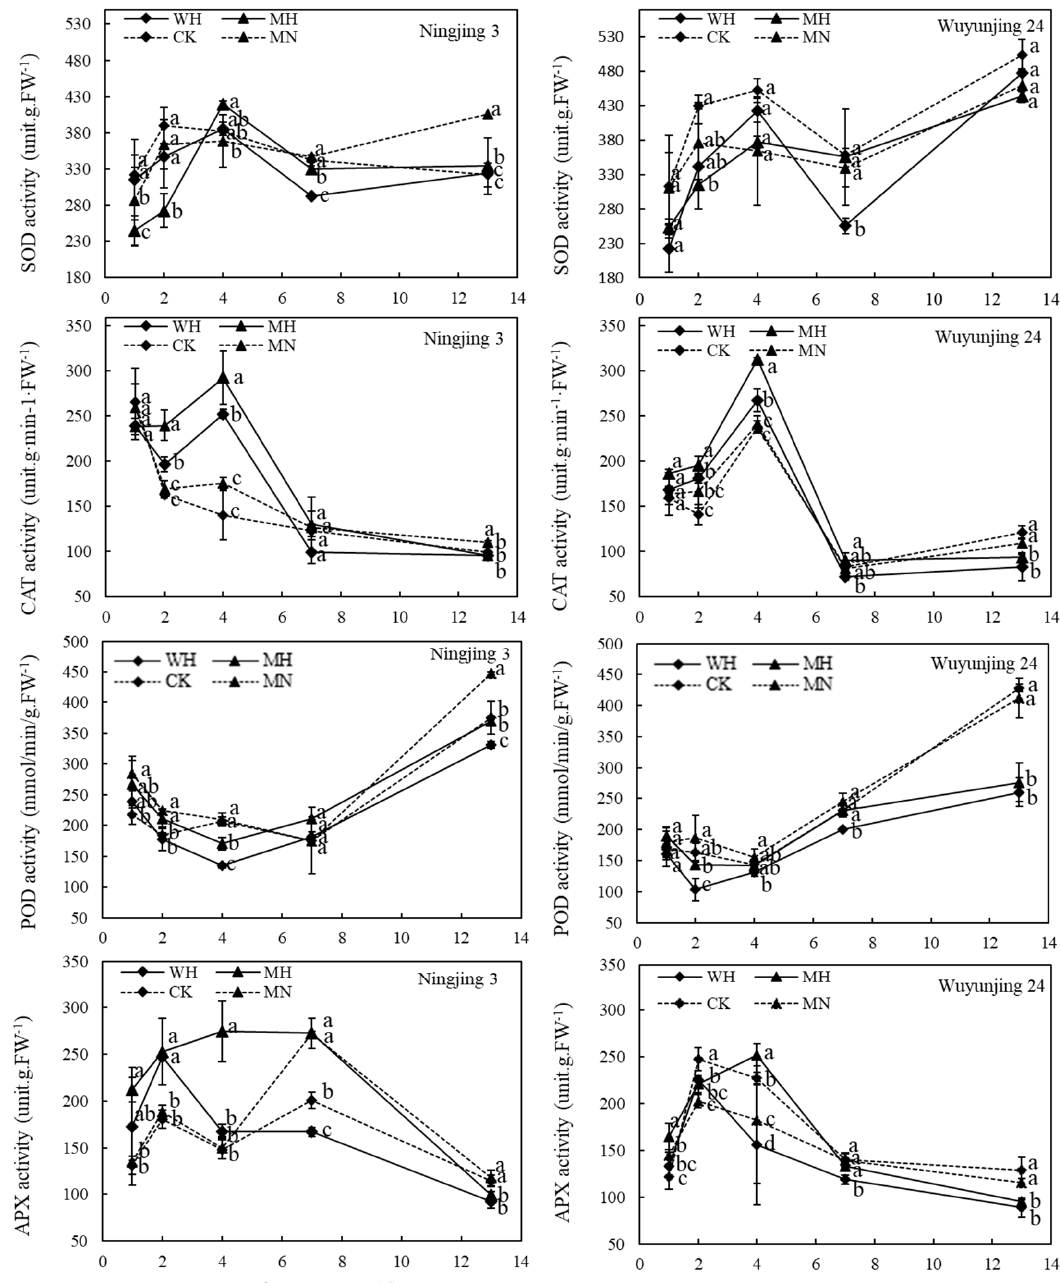
Figure 3. Effects of exogenous MeJA on the activities of SOD, POD, CAT, and APX of rice leaves at the booting stage under high temperatures. Note: CK: natural temperature and sprayed with water; MN: natural temperature and sprayed with MeJA; WH: heat stress and sprayed with water; MH: high temperature and sprayed with MeJA. SOD: superoxide dismutase; POD: peroxidase; CAT: catalase; APX: ascorbate peroxidase. Bars are the standard deviation. Values followed by different letters are significantly different at the 5% probability